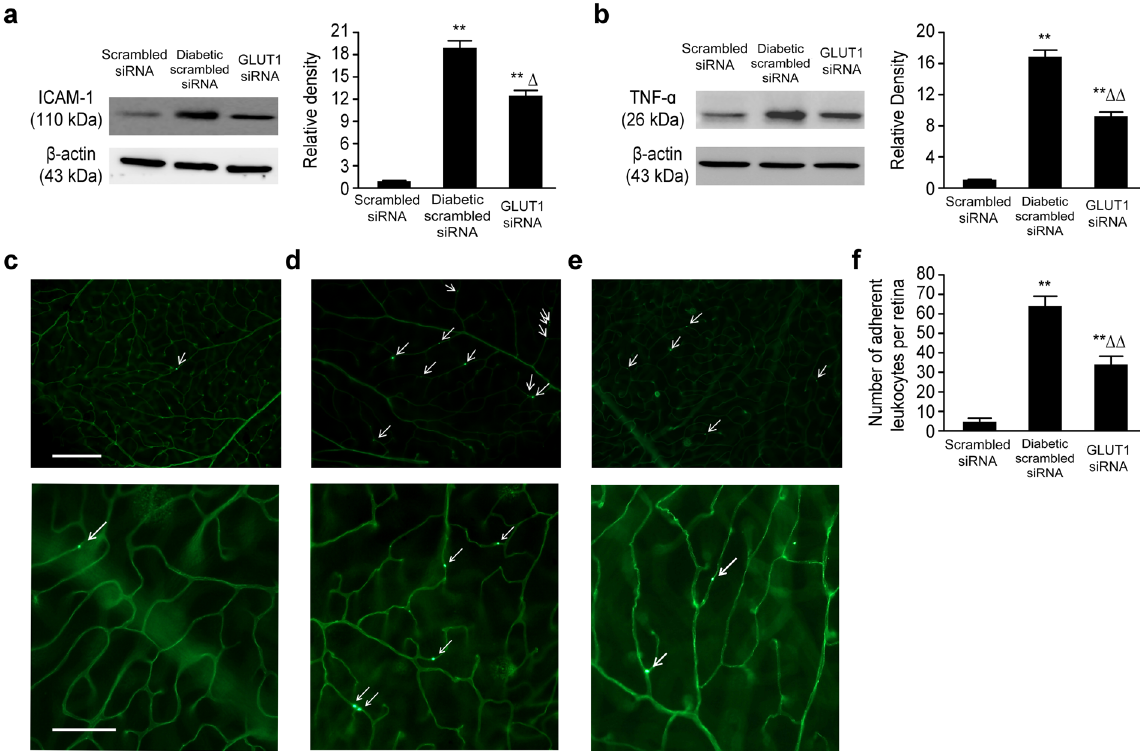
Figure 4. Inflammatory reactions in the retina of mice in the three groups. ( a ) Expression of retinal inflammation marker ICAM-1 in mice of the three groups ** P < 0.01 vs. scrambled siRNA group, Δ P < 0.05 vs. diabetic scrambled siRNA group, n = 6, x ± S. ( b ) Expression of retinal inflammation marker TNF- α in mice of the three groups, ** P < 0.01 vs. scrambled siRNA group, ΔΔ P < 0.01 vs. diabetic scrambled siRNA group, n = 6, x ± S, ( c–f ) Leukocytes adhesion to retinal vessel ( c ): scrambled siRNA group, scale bar represents 100 µ m (upper row images)/scale bar represents 50 µ m (lower row images); ( d ) diabetic scrambled siRNA group; ( e ) GLUT1 siRNA group; white arrows indicates adherent leukocytes; ( f ) statistical analysis ** P < 0.01 vs.